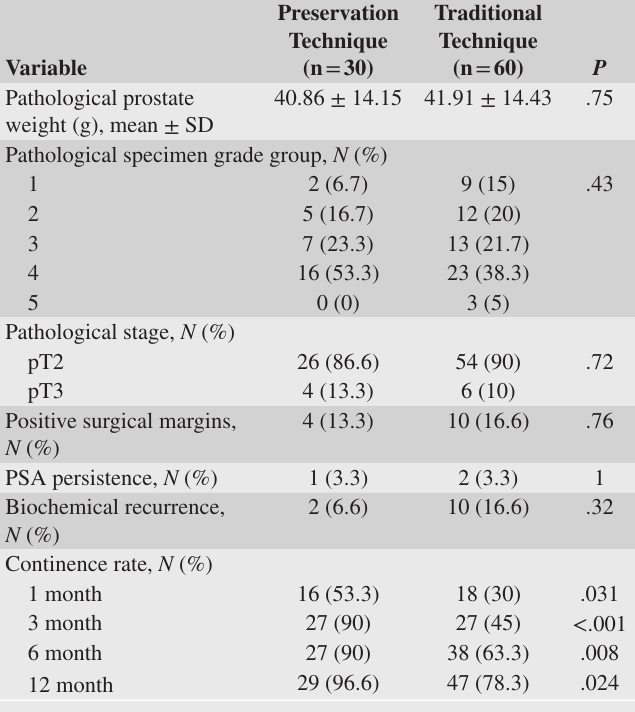
Table 3. Pathologic, Oncologic, and Continence